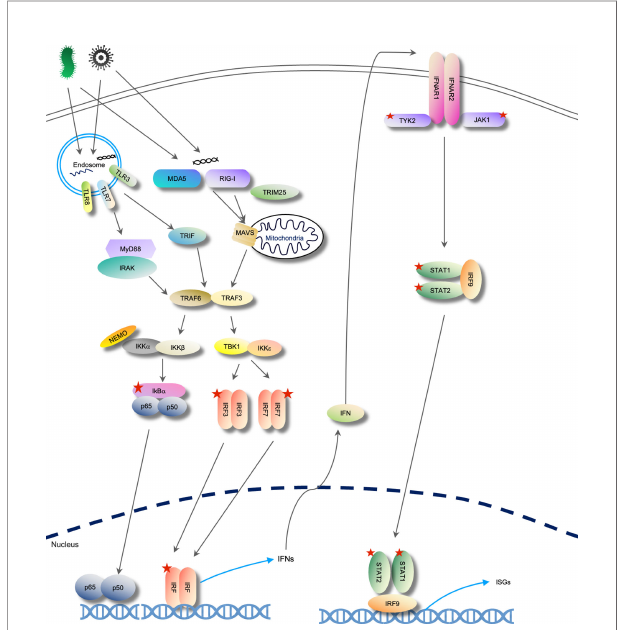
FIGURE 1 | RNA-mediated IFN-I signaling pathway. Pathogen invasion introduces RNA into the endosome or dsRNAs in the cytoplasm. Receptors recognize the RNA molecules and trigger the activation of downstream cascades through their adaptors. IFN-I expression is induced and secreted to activate the ISG expression through IFN-I receptors. Five-sided star represents phosphorylation modi fi